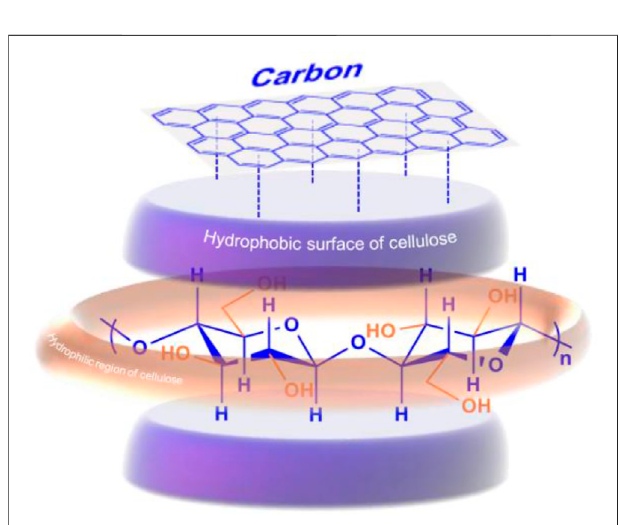
FIGURE 5 | Adsorption of cellulose onto carbon materials via the hydrophobic interactions between the axial faces of cellulosic materials and the polycyclic aromatic rings of carbon